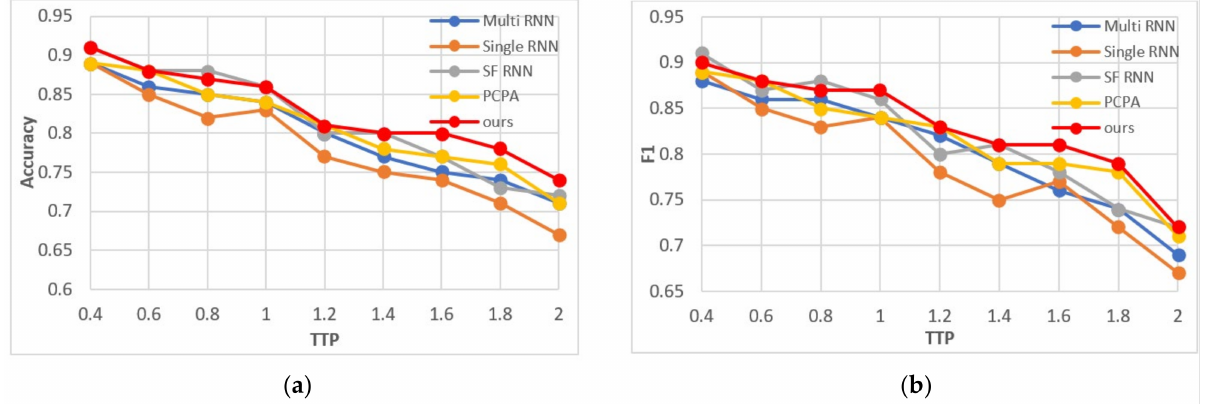
Figure 13. When the observation time is 0.53 s, the TTP is increased from 0.2 s to 2 s to test the performance of the algorithm. ( a , b ) represent accuracy and F1 parameter,